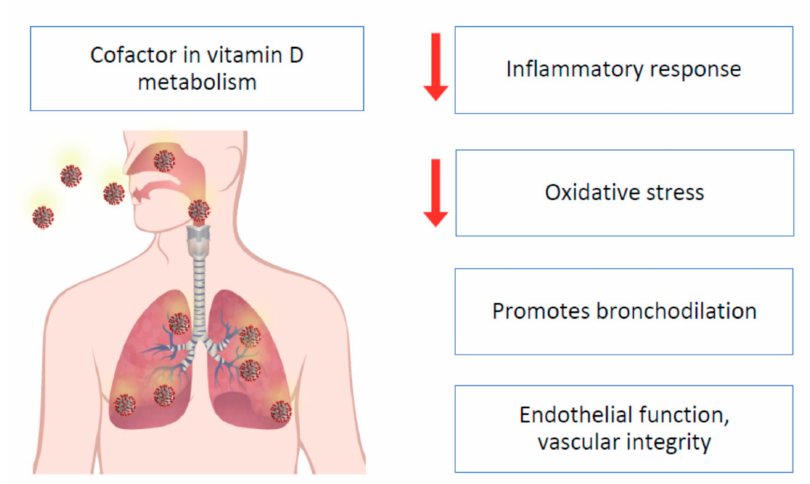
Figure 5. Summary of Mg’s possible effects in